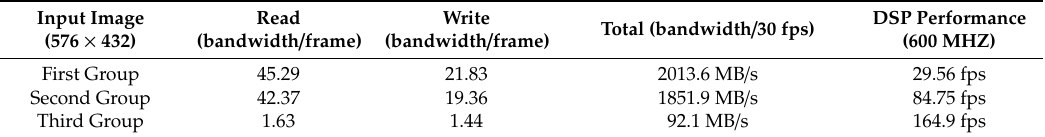
Table 5. Bandwidth and performance statistics.